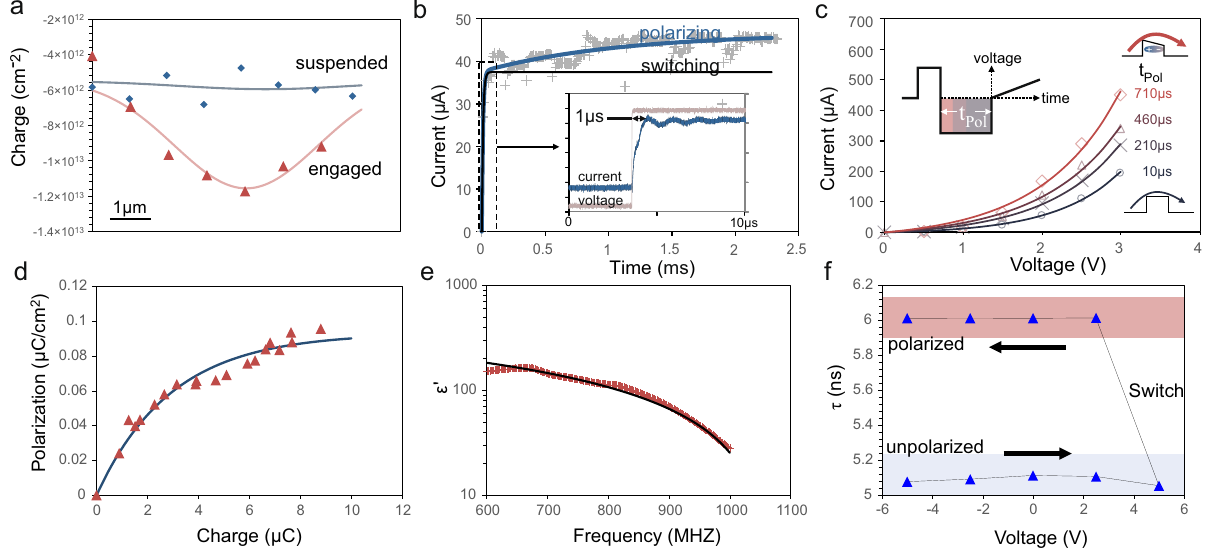
Fig. 2 Observation of ferroelectric polarization. a Spatial charge distribution across drum from Raman scaling analysis of drum in Fig. 1(d), ( b ) time- resolved current measurement with fi ts to switching ( τ ¼ 1 μ s) and polarization ( τ ¼ 1ms) processes, (inset) high speed measurement of switching transition, ( c ) current-voltage characteristics obtained by PUVD technique at different polarization conditions (inset) schematic of PUVD scheme, ( d ) time evolution of polarization with charging, ( e ) high-frequency measurement of dielectric constant with fi t to Debye relaxation model, ( f ) plot of extracted relaxation time constant τ during